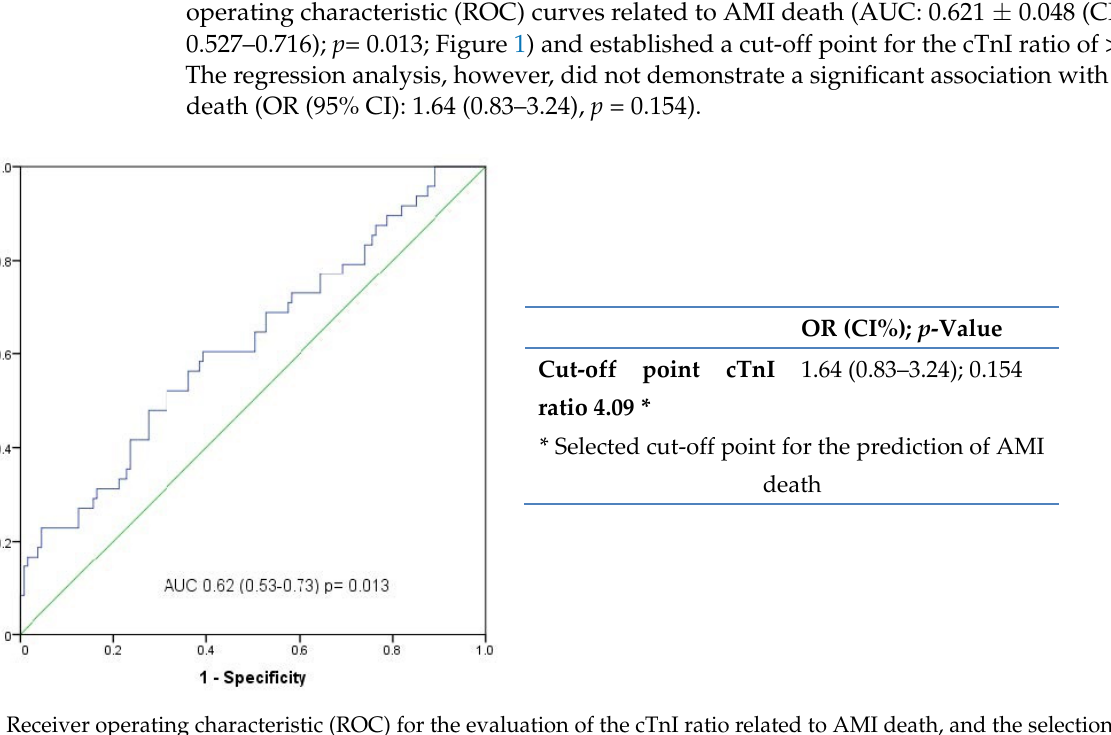
Figure 1. Receiver operating characteristic (ROC) for the evaluation of the cTnI ratio related to AMI death, and the selection of the cTnI ratio cut-off point in the prediction of AMI death (lineal regression).